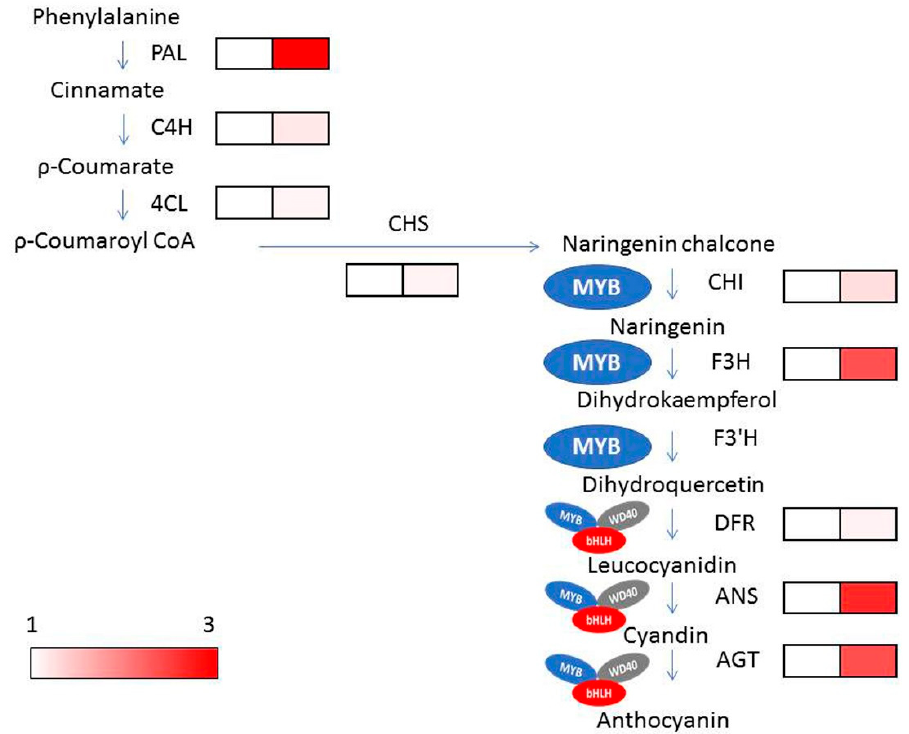
Figure 9. Relative expression patterns of the early and late-structural genes of anthocyanin biosyn- thesis in leaf samples of pl and WT. Colored scales indicate the levels of gene expression.